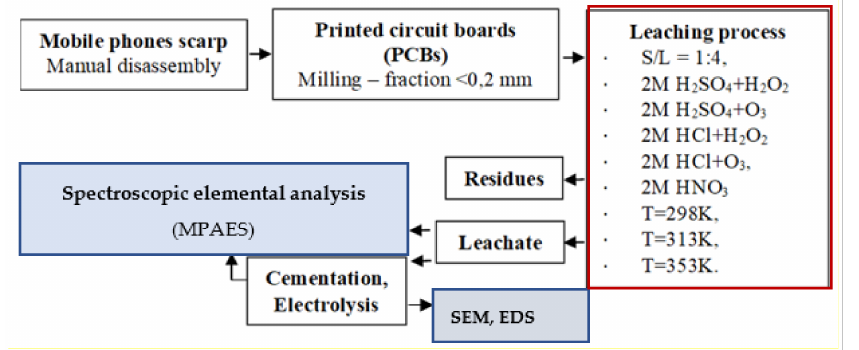
Figure 2. Scheme of the conducted research; the stages of leaching process of Au, Ag, Pd, Cu, and Sn from PCBs; and analysis of prepared